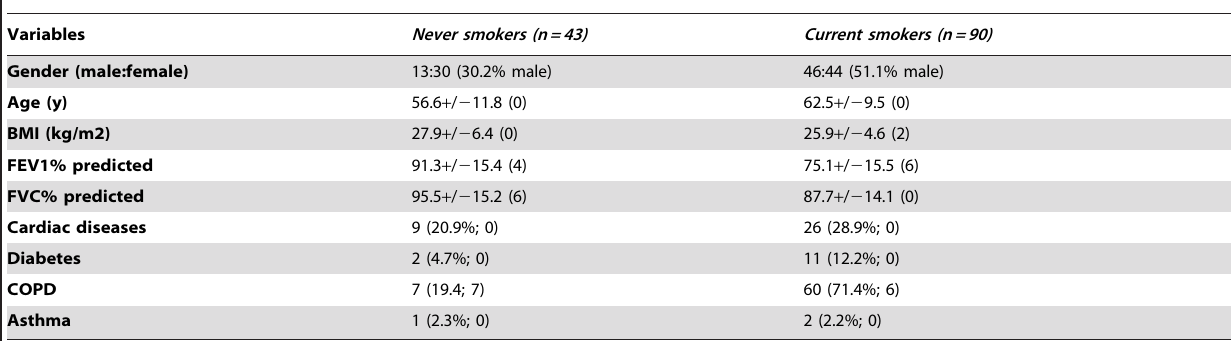
Table 1. Clinical characteristics of subjects.